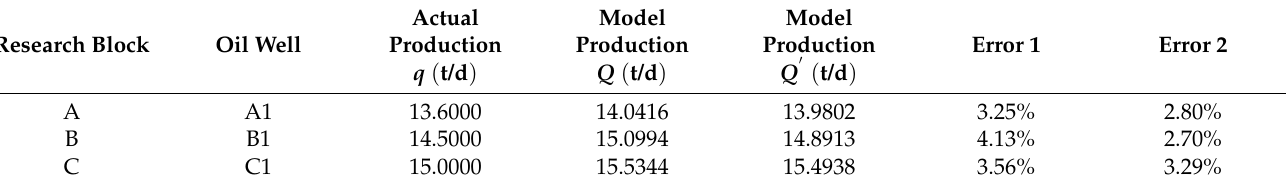
Table 4. Model verification results.